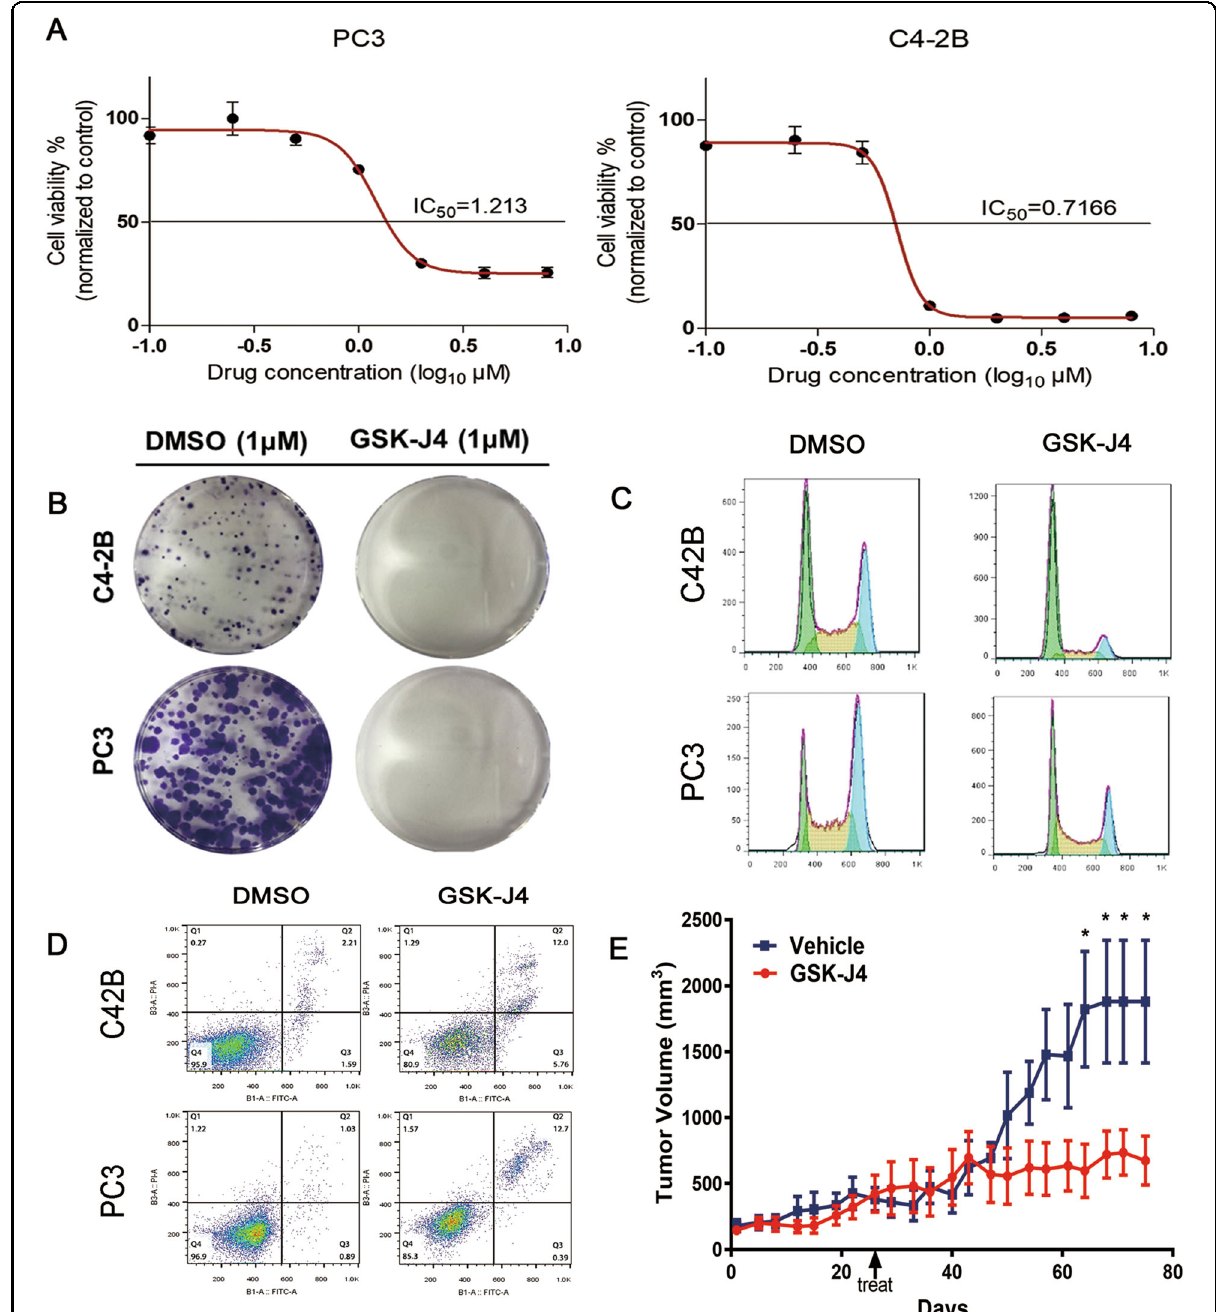
Fig. 3 GSK-J4 inhibits cellular function and in vivo experiments. A The IC50 values of GSK-J4 for viability inhibition in PC3 and C42B cells are shown. Error bars means SD, n = 3 independent repeats. B The colony formation abilities of PC3 and C42B cells treated with GSK-J4 are shown. C A cell cycle analysis of PC3 and C42B cells treated with GSK-J4 was performed. D An apoptosis analysis of PC3 and C42B cells treated with GSK-J4 was performed. E The growth curve of subcutaneous xenograft of C42B cells treated with GSK-J4. Error bars mean SD, six mice in each group (* p <